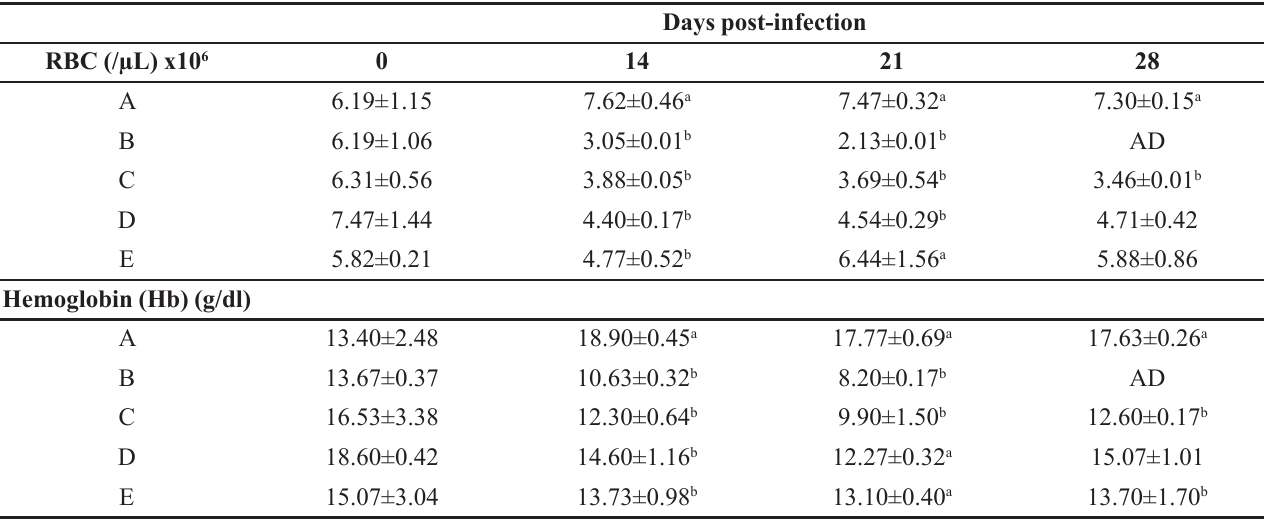
TABLE II - Mean RBC counts and Hemoglobin concentrations in dogs infected with T. b. brucei and treated with combinations of SEC-DA and DA alone